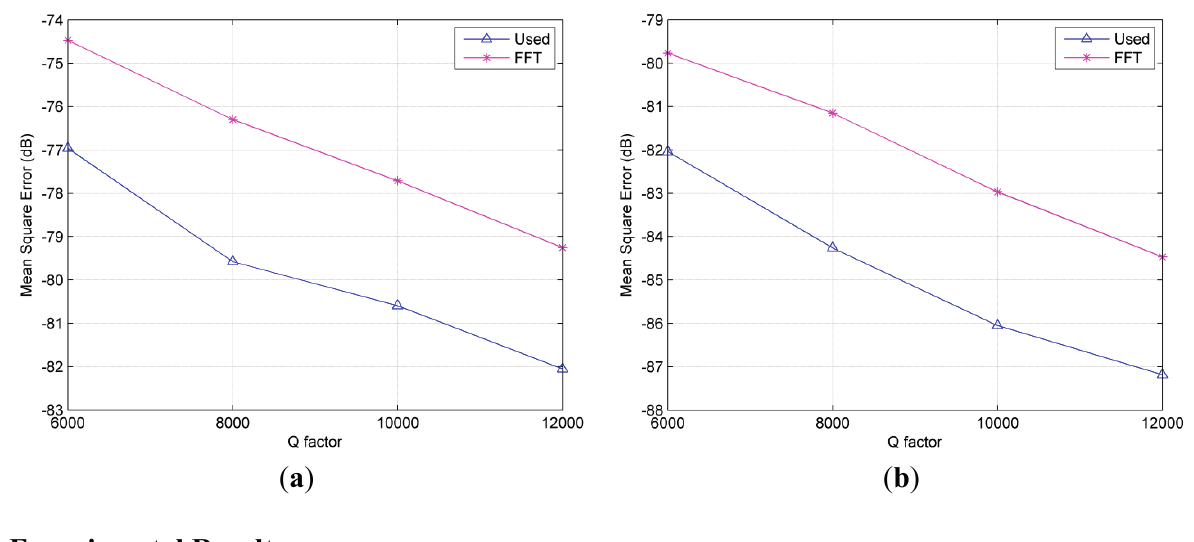
Figure 4. Comparisons of measurement resolution at different SNR levels. ( a ) SNR level = 5 dB ( b ) SNR level = 10 dB.